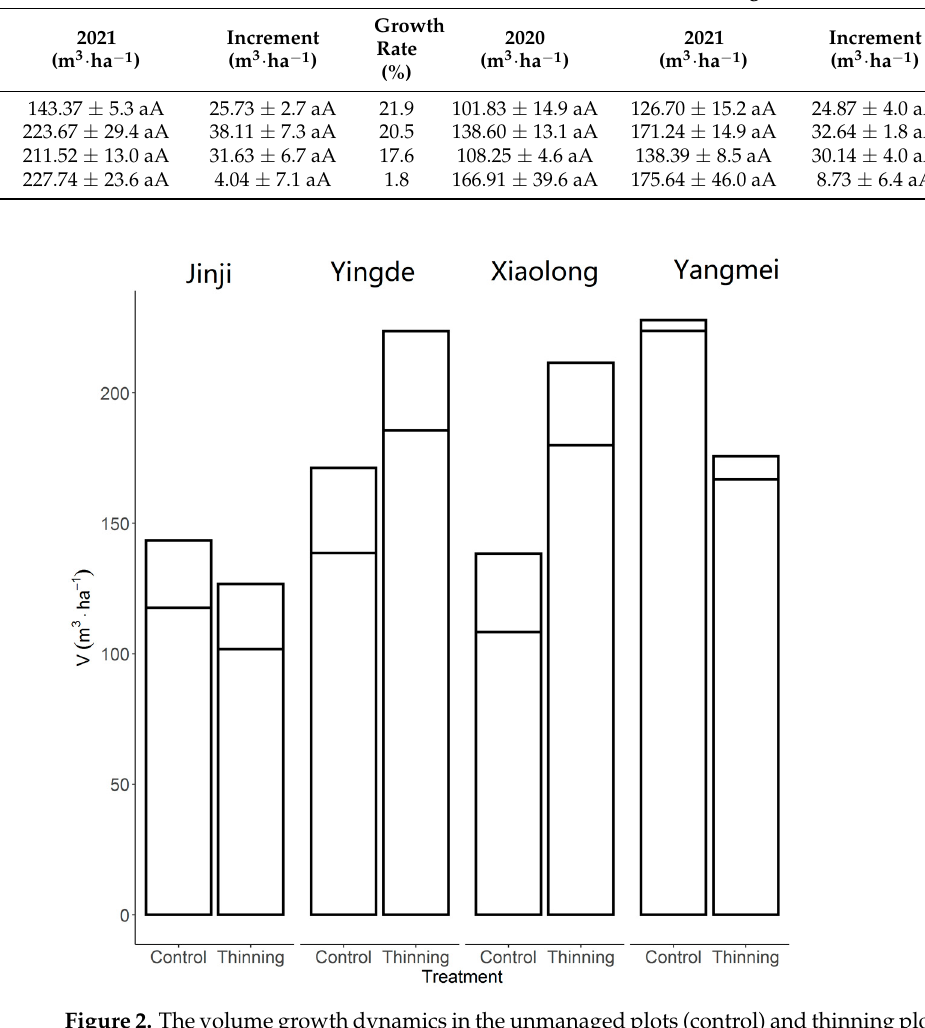
Figure 2. The volume growth dynamics in the unmanaged plots (control) and thinning plots (thinning) in Yangmei, Jinji, Yingde, and Xiaolong forest farms. The cap of the bar is the mean forest volume increment since the treatments were applied.